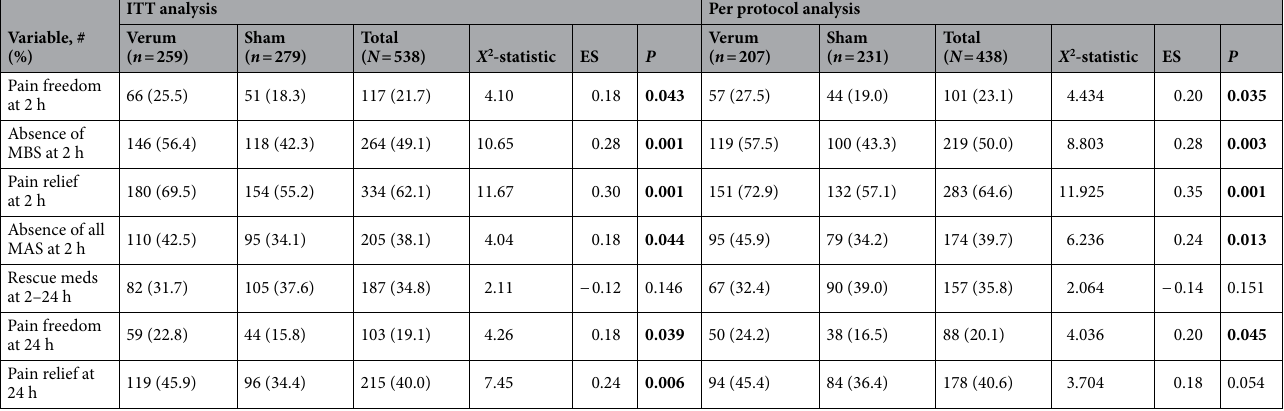
Table 3. Headache pain outcomes following e-TNS session: Verum vs. Sham. MBS most bothersome symptom, MAS migraine-associated symptoms, ES effect size.